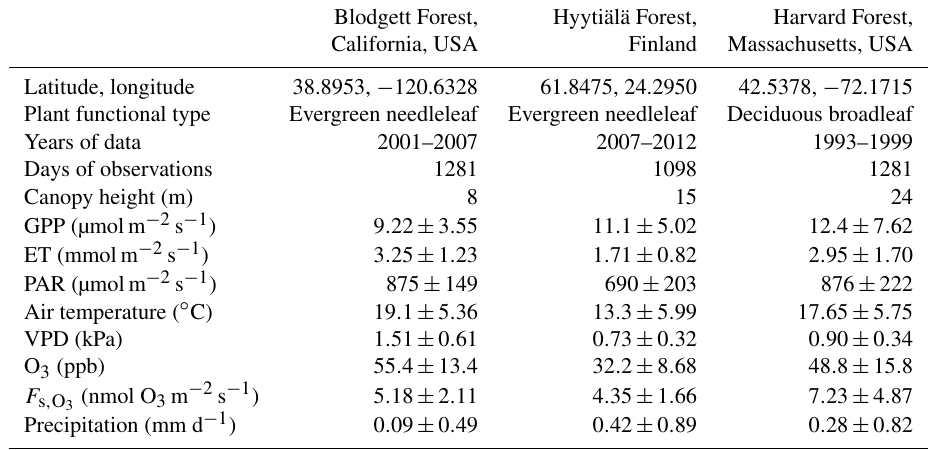
Table 1. Description of sites that measure O 3 flux and their daytime growing season conditions ∗ .